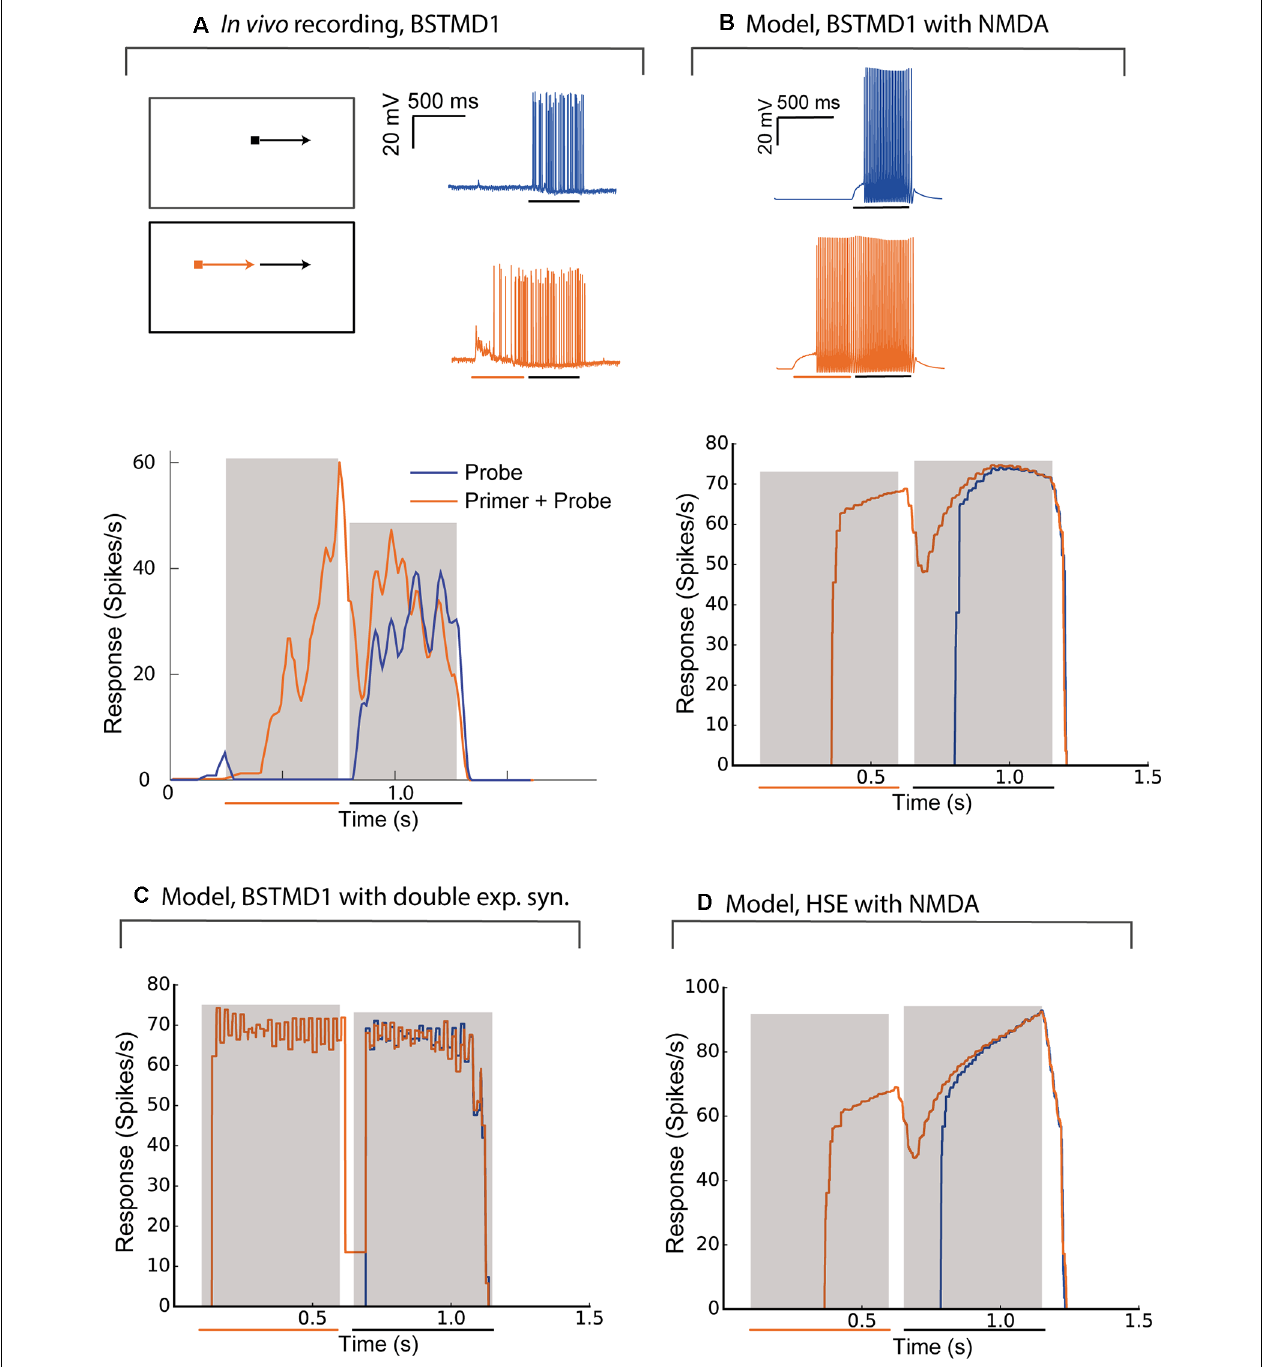
FIGURE 5 | The model behaves similarly to intracellular recordings of BSTMD1. Example BSTMD1 intracellular electrophysiology data of stimuli involving a probe (moving target) with or without a primer (moving target before the probe appears). (A) In vivo BSTMD1 recording of primer+probe experiment. (B) BSTMD1 model ( g max = 40 pS) with NMDA synapses. (C) BSTMD1 model ( g max = 120 pS) double exponential synapses instead of NMDA synapses. (D) HSE model ( g max = 135 pS) with NMDA synapses.